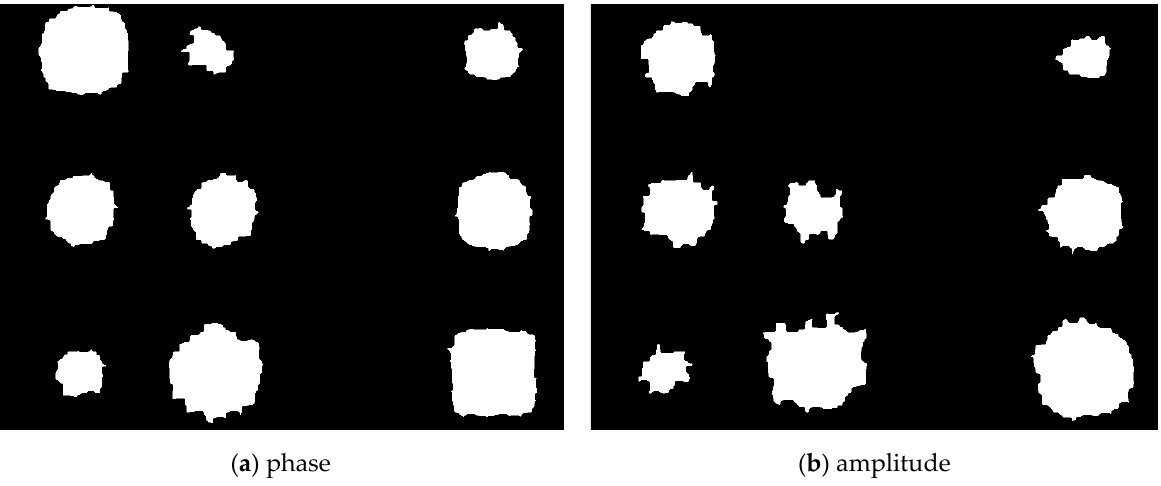
Figure 13. Binary images with de-noising performed using morphology operation.